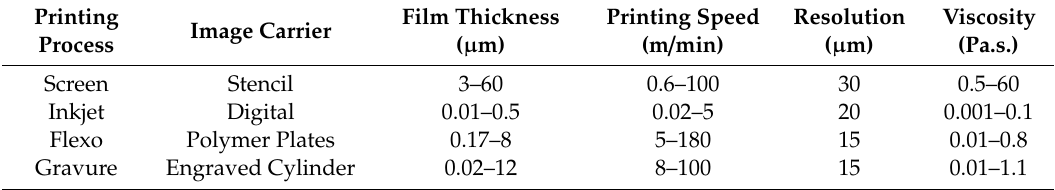
Table 3. Specifications of printing techniques employed in printed